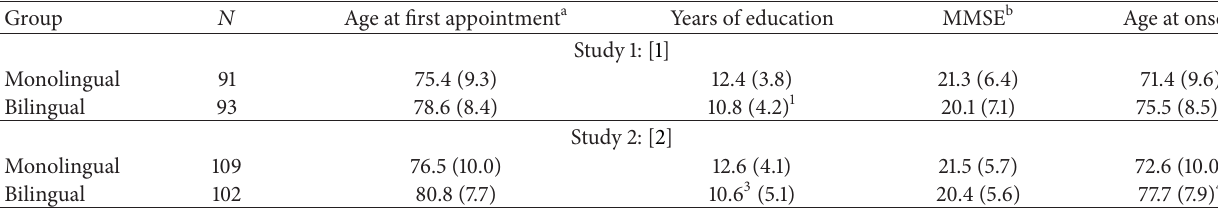
Table 1: Means (and standard deviations) for background measures and age of onset of symptoms of dementia from the two Toronto studies. Group 𝑁